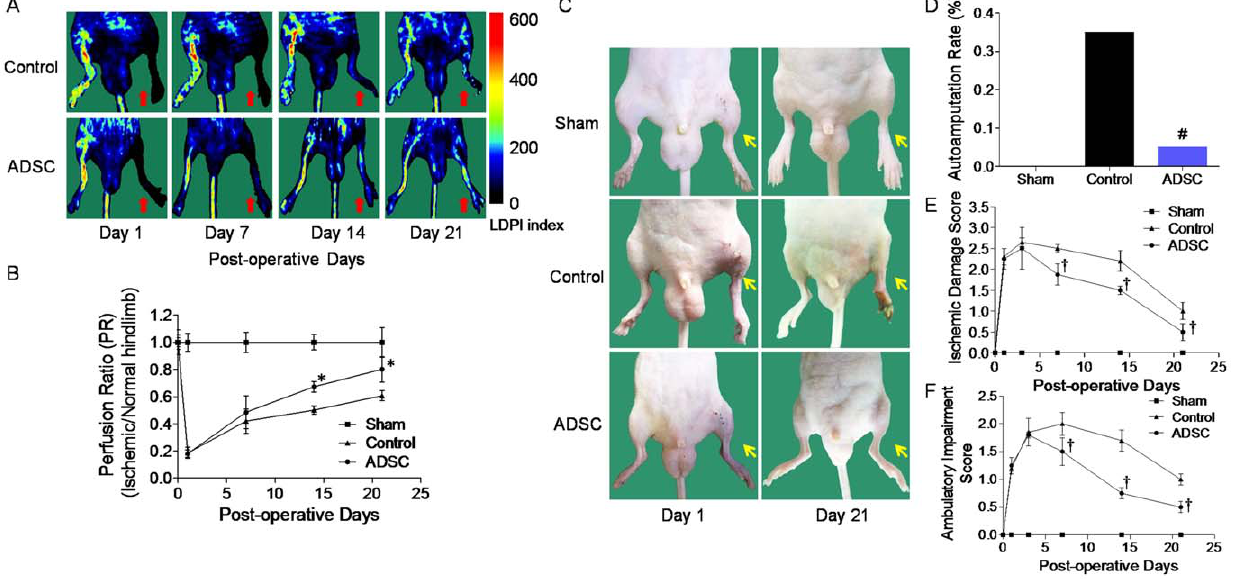
Figure 4. Blood perfusion imaging and function assessment of ischemic hindlimb. Laser Doppler perfusion imaging (LDPI) visualized dynamic changes in hindlimb perfusion ( a ). Colored scale bar represents blood flow velocity in LDPI index. Blood perfusion was quantified using perfusion ratio (PR), i.e., the ratio of average LDPI index of ischemic (red arrows) to nonischemic hindlimb ( b ). Representative photos show hindlimb autoamputation or salvage (yellow arrows) among groups on day 21 ( c ). Significantly lower autoamputation percentage ( d ), scores of ischemic damage ( e ) and ambulatory impairment ( f ) were observed in the ADSC group compared to the control group. n=20 for each. Error bars: mean 6 SD. * P , 0.001 vs. Control, # P , 0.05 vs. Control, { P , 0.001 vs. Control.